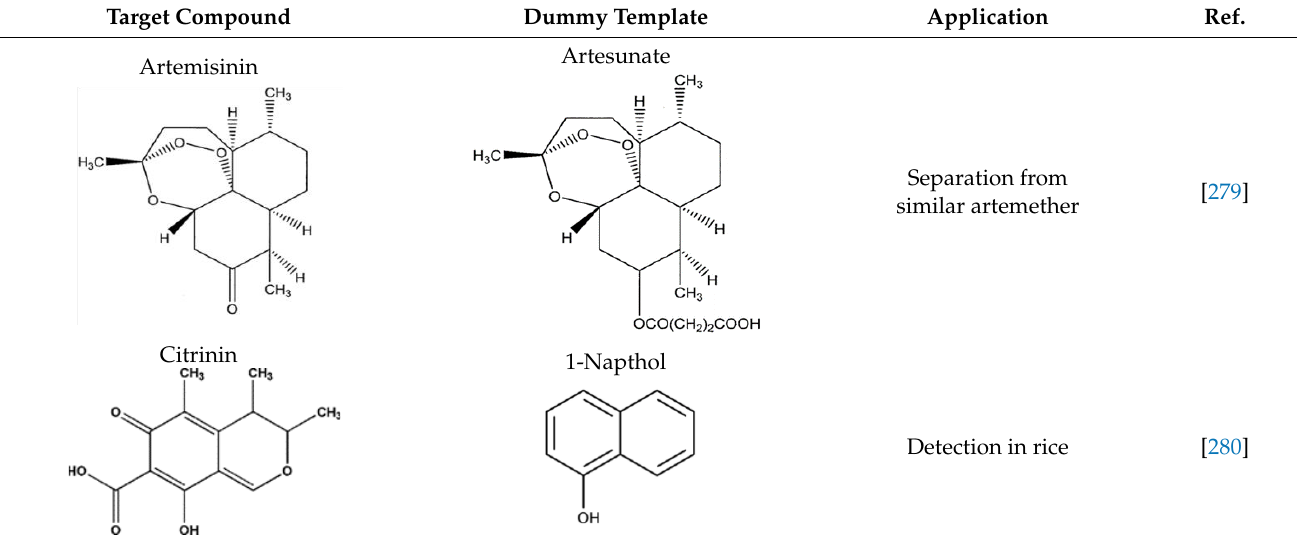
Table 3. Some target molecules and their relative dummy template used in green MIMs production. Target Compound Dummy Template